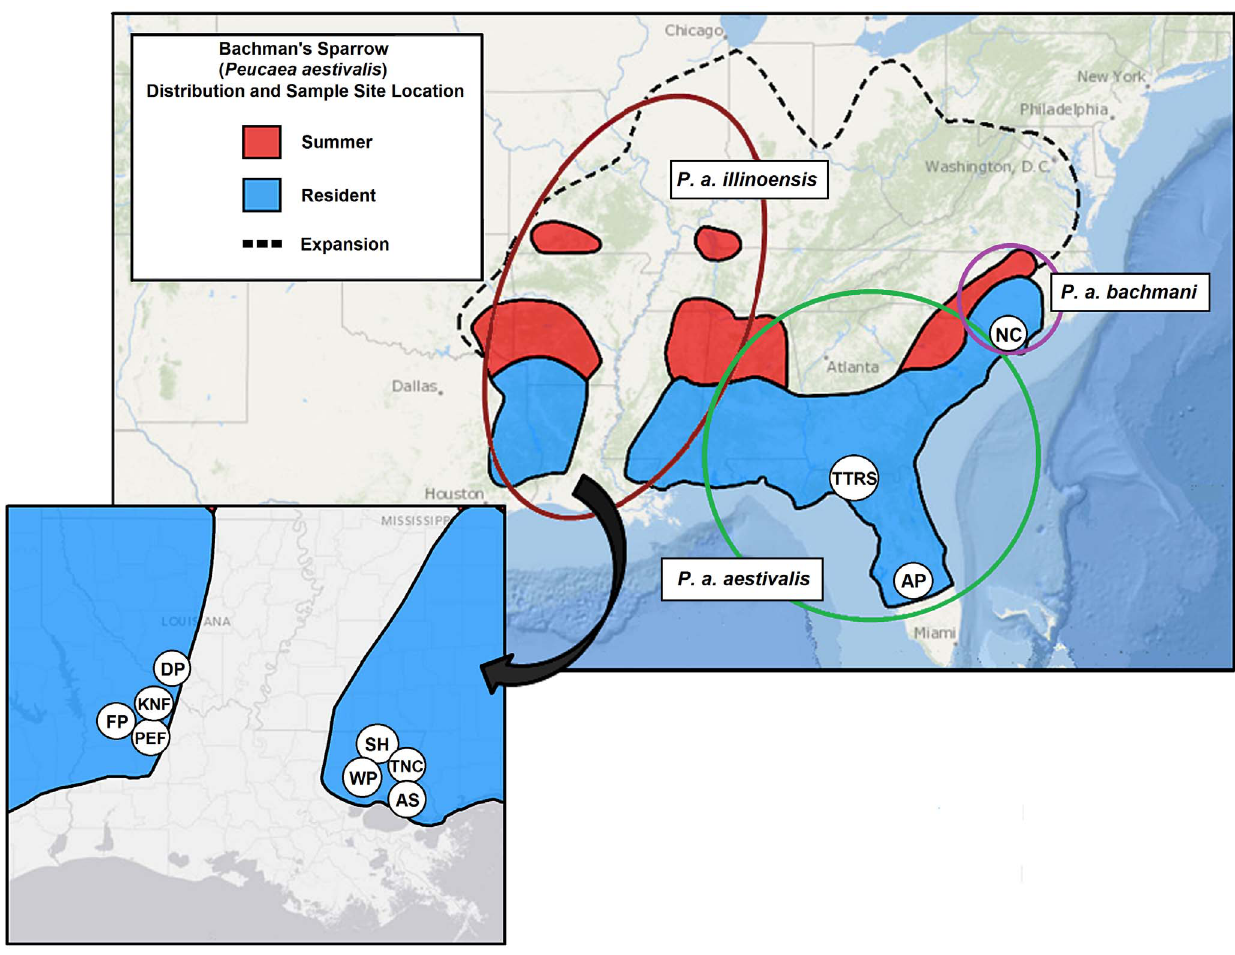
Figure 1. Bachman’s Sparrow distribution including historic range expansion and subspecific ranges. Ranges as described by the AOU [21] and Dunning [74]. Sampling locations include: Fort Polk WMA (FP), Palustris Experimental Forest (PEF), Kisatchie National Forest (KNF), Dry Prong WMA (DP), Camp Whispering Pines (WP), Sandy Hollow WMA (SH), Talisheek Pines Wetland Preserve (TNC), Abita Springs (AS), Tall Timbers Research Station (TTRS), Avon Park Air Force Range (AP), and North Carolina